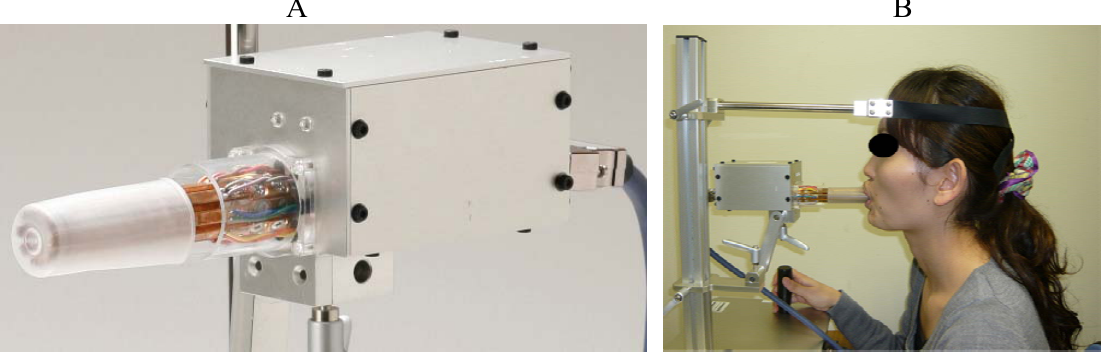
Figure 4. Apparatus for measurement of multidirectional lip-closing force using strain gauges. A: probe, B: patient set-up. The subject’s head is fixed, with Camper’s line parallel to the probe. The subject is instructed to close the lips with maximum